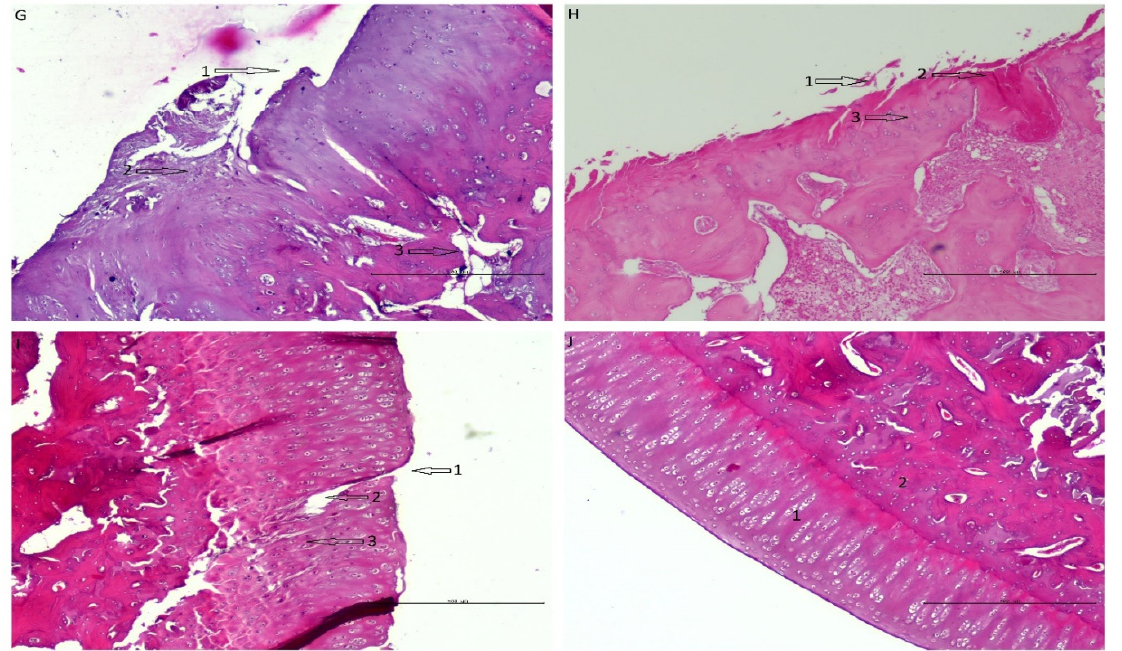
Figure 9. Shows histological samples of the cartilage of the rabbit of the studied groups. The following observations were made by one histologist. ( A ) PVP group after 8 weeks of observation—the defect is easily visible; (1) the surface has irregularities, (2) cells are disorganized, (3) increased remodeling of subchondral bone. ( B ) Z group after 8 weeks of observation—the defect is easily visible; (1) the surface has irregularities, (2) cartilage necrosis, (3) cells are distributed in clusters (4) chondral fracture reaching the subchondral bone. ( C ) Control group after 8 weeks of observation—the defect is easily visible; (1) the surface has irregularities, (2) massive loss of subchondral bone, (3) Bone fractures with the separation of necrotic fragments. ( D ) PVP group after 16 weeks of observation; (1) cells are distributed in clusters, (2) cartilage fracture, the surface has irregularities; (3) porous subchondral bone in some places, otherwise normal. ( E ) Z group after 16 weeks of observation—the defect is easily visible; (1) cells are distributed irregularly, (2) the surface is torn, (3) porous subchondral bone in some places, otherwise normal. ( F ) control group after 16 weeks of observation—the defect is easily visible; (1) the surface is torn, (2) chondral fractures reaching the subchondral bone, (3) cells are distributed irregularly. ( G ) PVP group after 24 weeks of observation; (1) the surface is torn/has irregularities, (2) cartilage fractures, cells are distributed irregularly, (3) increased remodeling of subchondral bone. ( H ) Z group after 24 weeks of observation; (1) the surface is torn, (2) necrosis, (3) cells are distributed in columns. ( I ) Control group after 24 weeks of observation; (1) the surface has irregularities; (2) full thickness chondral fracture; (3) cells are distributed irregularly. ( J ) Histological image of correct hyaline cartilage in rabbit model—(1) cartilage, (2) subchondral